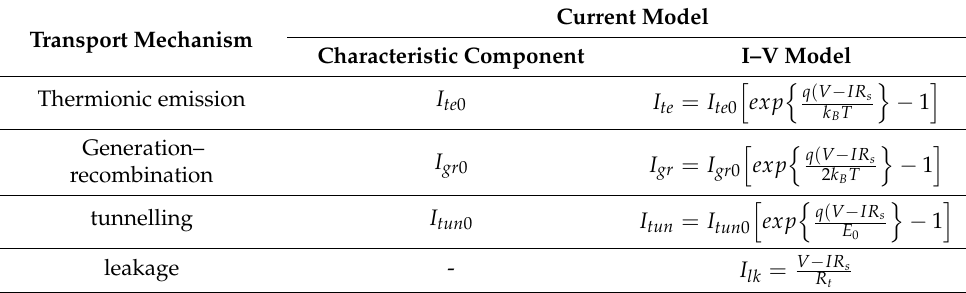
Table 1. Physical mechanisms of the electrical conduction of the p -GaAs Schottky diode. We obtained the current–transport components by adopting all of the detailed fitting methods in Ref.